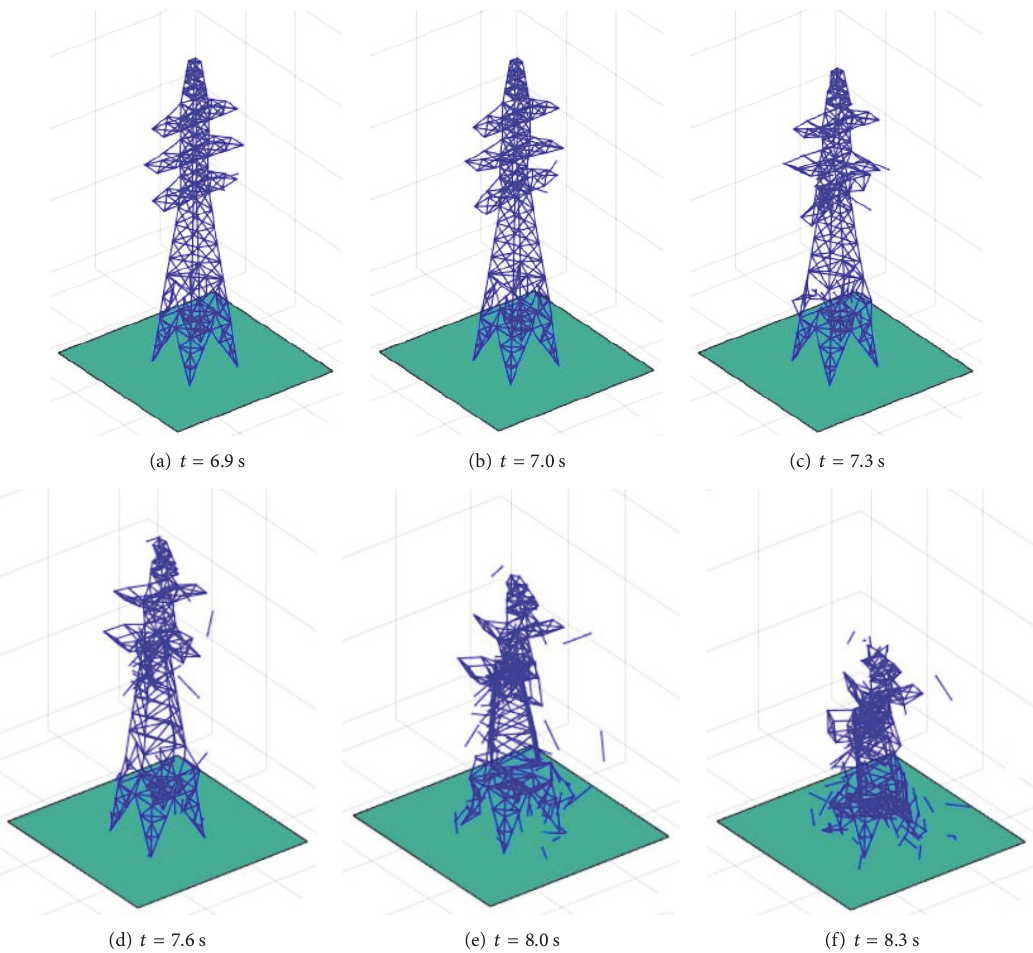
Figure 18: Failure process of the transmission tower at different